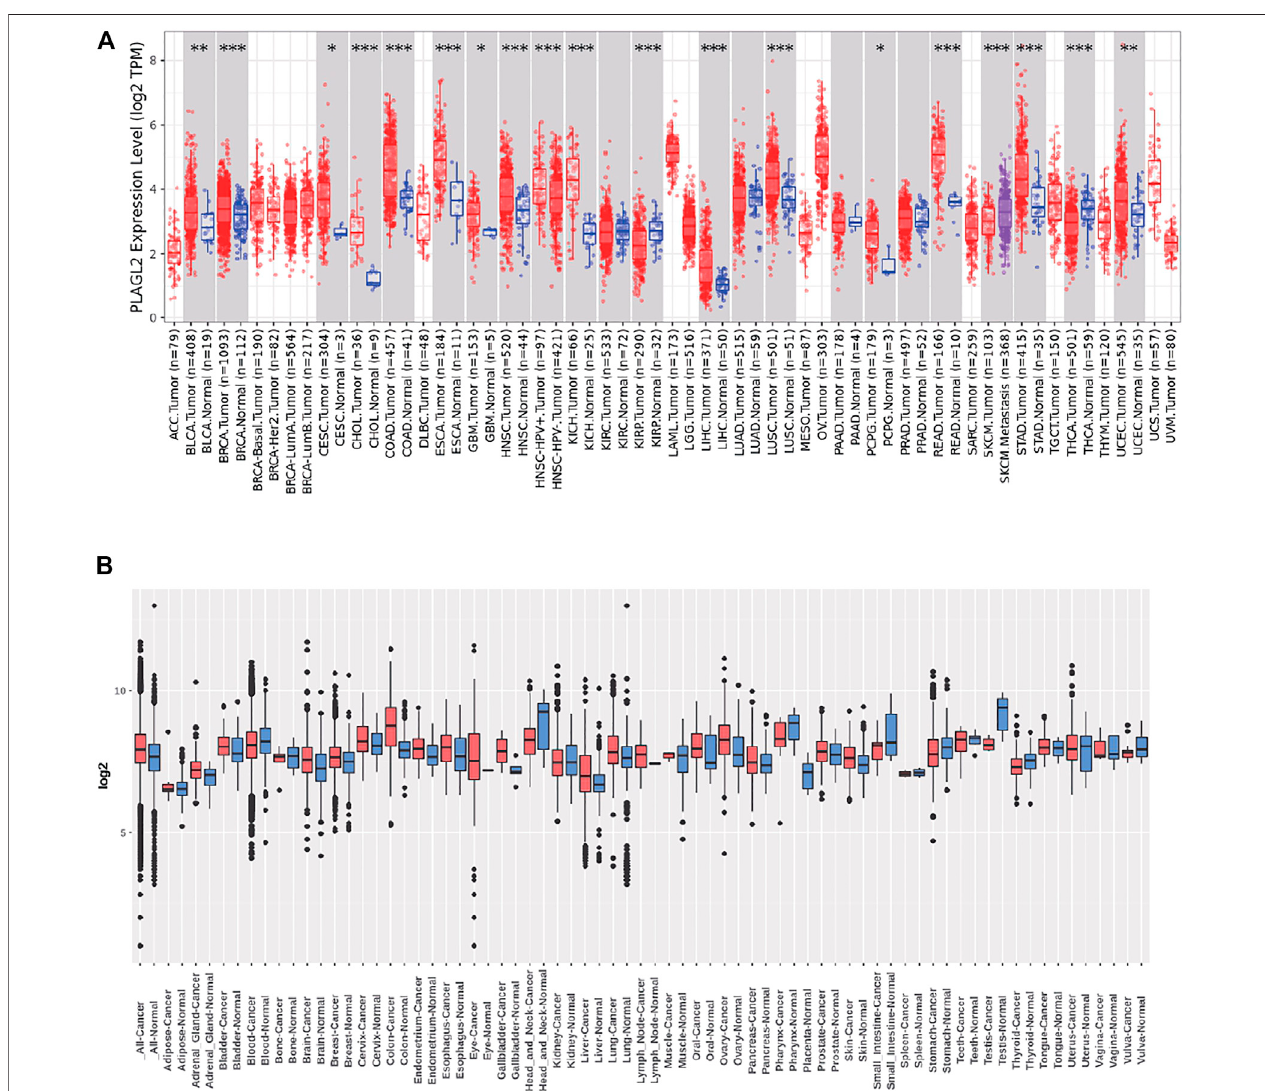
FIGURE1 | Tissue-widemRNA expression pro fi le of PLAGL2 across different types ofcancer using the TIMER and GENT2 databases. (A) Expression ofPLAGL2 in different types of cancers compared with healthy tissues in data derived from TIMER2.0 database. (B) PLAGL2 mRNA expression pattern in various tumor types was obtainedfromtheGENT2database.Redboxplotspeci fi esvariouscancersamples,whereasblueboxplotdesignatesnormalsamples.* p < 0.05,** p < 0.01,** p < 0.001.